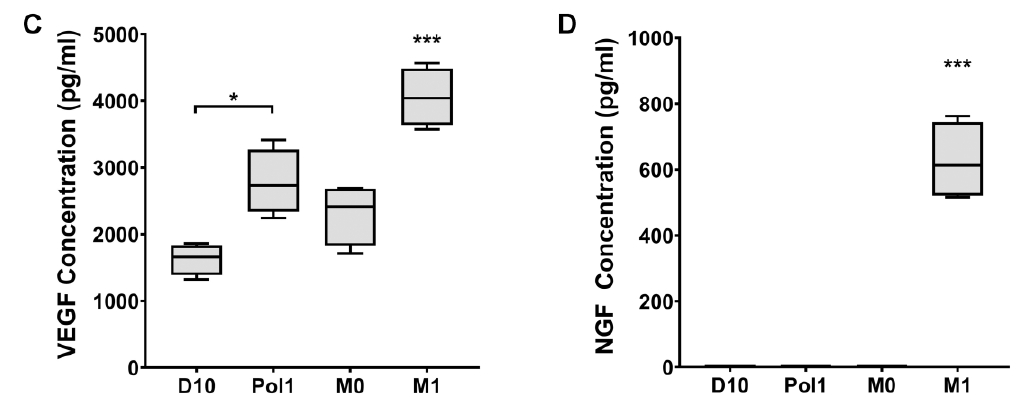
Figure 6. Secretome analysis. Growth factor concentration in MSC conditioned medium after 24 h conditioning was measured with immunoassays. ( A ) Box plot of the concentration of GDNF in MSC CM across conditions. M1CM con- ditioning induces significantly higher secretion of GDNF compared to the three controls. Pol1 conditioning induces significantly higher secretion of GDNF than M0CM. ( B ) Box plot of the concentration of HGF in MSC CM across conditions. M1CM conditioning induces significantly higher secretion of HGF compared to M0CM. ( C ) Box plot of the concentration of VEGF in MSC CM across conditions. M1CM conditioning induces significantly higher secretion of VEGF compared to the three controls. Pol1 conditioning induces significantly higher secretion of VEGF than regular D10. ( D ) Box plot of the concentration of NGF in MSC CM across conditions. M1CM conditioning induces significantly higher secretion of NGF compared to controls. Asterisks represent the level of significance on one-way ANOVA test ( A , C , D ) or Kruskall–Wallis test ( B ), with * = p < 0.05 and *** = p < 0.0005. Error bars indicate minimum and maximum values. Abbreviations: GDNF: glial-derived neurotrophic factor; HGF: hepatocyte growth factor; VEGF: vascular endothelial growth factor; NGF: neural growth factor; CM: conditioned medium; D10: MSCs conditioned with DMEM medium with 10% fetal bovine serum; M0: MSCs conditioned with M0CM; M1: MSCs conditioned with M1CM; Pol1: MSCs conditioned with pro-inflammatory polarization